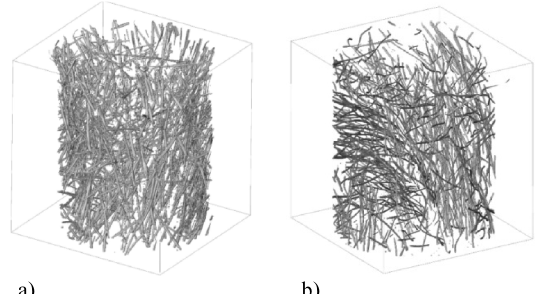
Fig. 9. 3-D X-rays: a) 3-D X-rays taken from top sample; b) 3-D X-rays taken from bottom sample